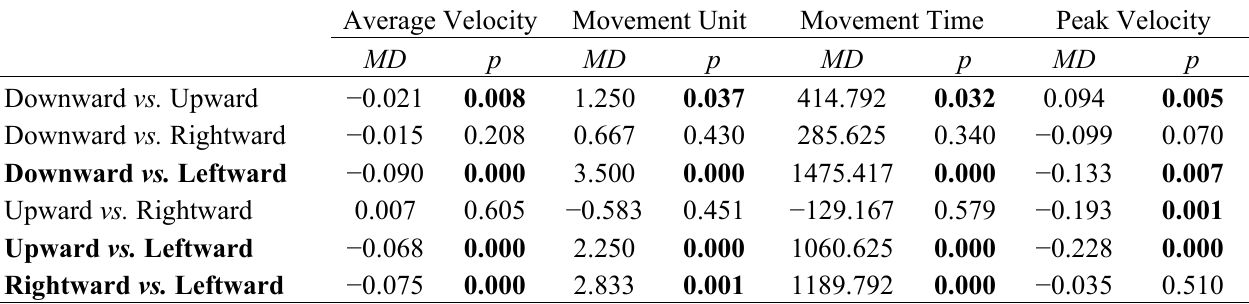
Table 3. LSD post-hoc